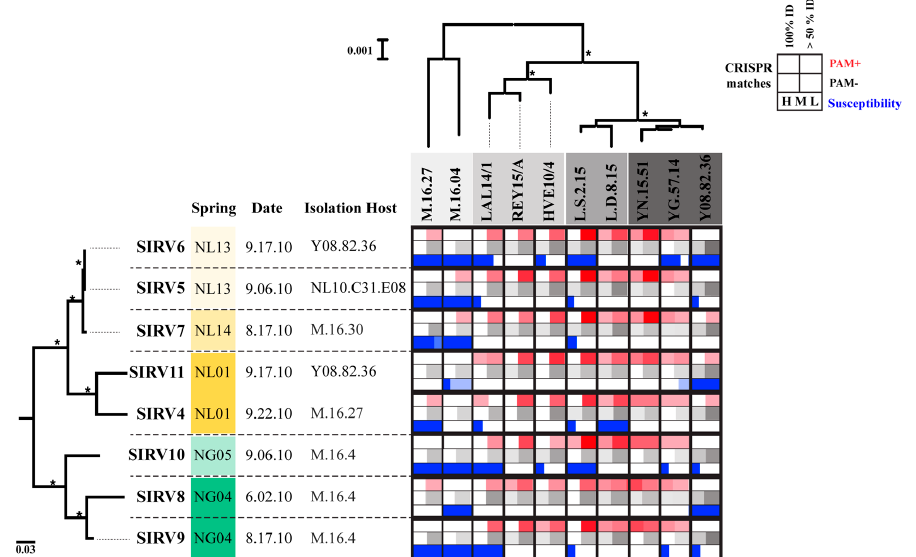
Figure 3. Sulfolobus islandicus susceptibility and CRISPR (clustered regularly interspaced short palindromic repeats) spacer matches against Yellowstone SIRVs. Blue bars indicate that a zone of clearing was formed at high (H) 1 × 10 7 pfu (plaque forming units)/ml, medium (M) 1 × 10 6 pfu/mL or low (L) 1 × 10 4 pfu/mL viral challenge. Darkest blue denotes that a zone of clearing was formed on that host on all three replicates, lightest blue denotes that a plaque was formed only on one of the replicates, and white denotes that no clearing was formed in any of the replicates. Presence of CRISPR matches with a protospacer adjacent motif PAM (red) and without a PAM (grey) are shown. A darker shade represents a higher number of matches. Empty cells indicate that no matches fit the criteria. Tree above S. islandicus host strains represents a Maximum Likelihood phylogeny of a concatenated nucleotide alignment of 12 MLSA (multilocus sequence analysis) loci for these strains. Asterisks on branches indicate bootstrap support >80% as a percent of 1000 replicates. Scale bar represents substitutions per